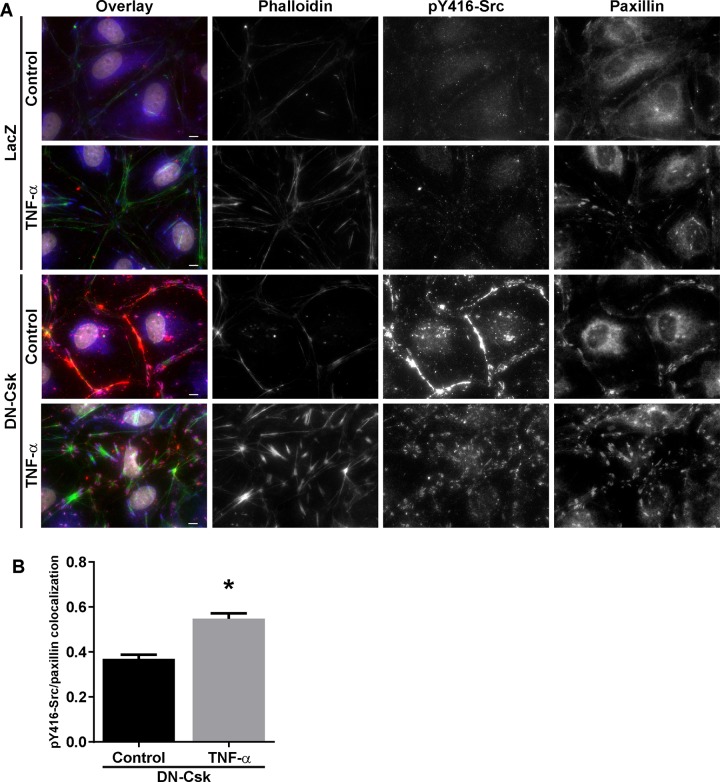
Csk inhibition alters the actin remodeling induced by TNF-α treatment.Cells were seeded at confluence and incubated for 72 hours. Then, growth media was replaced by low serum media and cells were infected with adenovirus to express either LacZ (control) or DN-Csk. After another 16 h, cells were treated with low-dose TNF-α. Cells were fixed at 6 h post TNF-α treatment. A, Immunofluorescence microscopy was performed to detect pY419 Src, paxillin and F-actin (phalloidin). Nuclei were counterstained with DAPI. B, Pearson’s coefficient was calculated to assess the level of colocalization between active SFK and paxillin signals in DN-Csk-expressing cells. Asterisk, p<0.05 (Student’s T test, 6 fields per condition). Note the drastic relocalization of active Src from the cell-cell junctions to cell-matrix adhesions upon dual DN-Csk and TNF-α treatments, together with a loss of cortical actin and the appearance of short and thick actin bundles. Results are representative of at least four independent experiments.